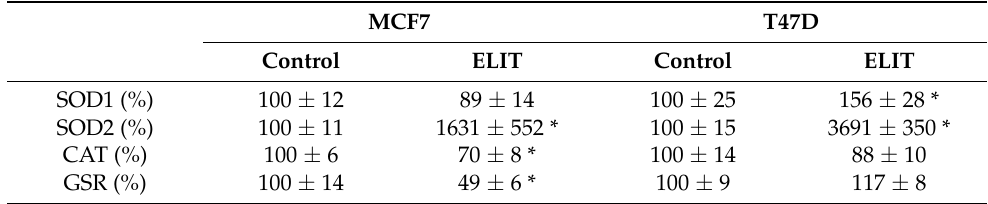
Table 3. Antioxidant enzymes protein levels in MCF7 and T47D breast cancer cell